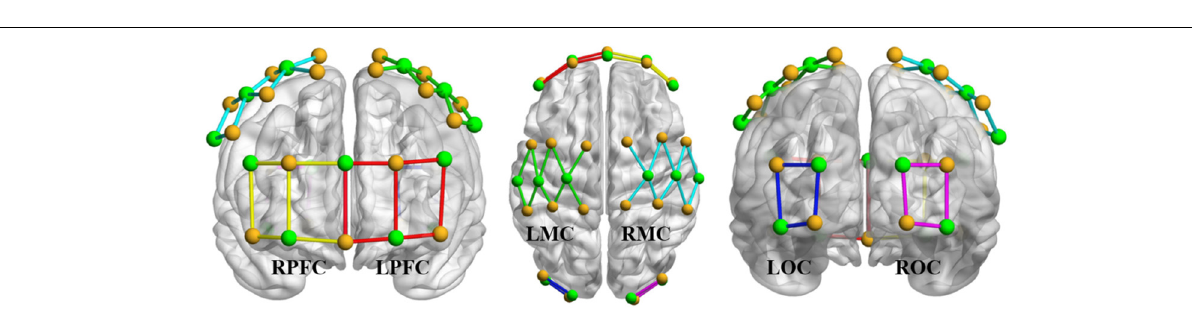
Frontiers in Human Neuroscience |